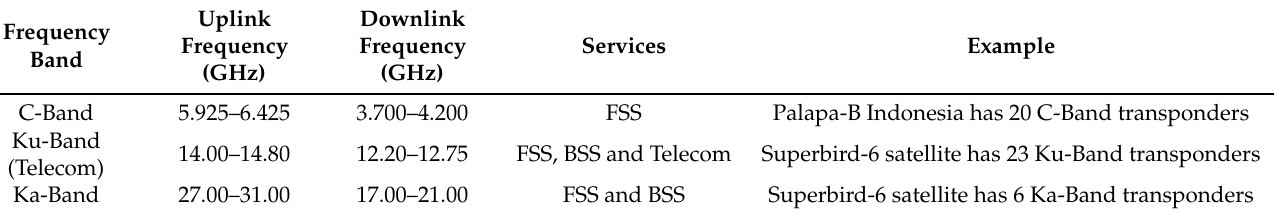
Table 3. Satellite Band Uplink and Downlink